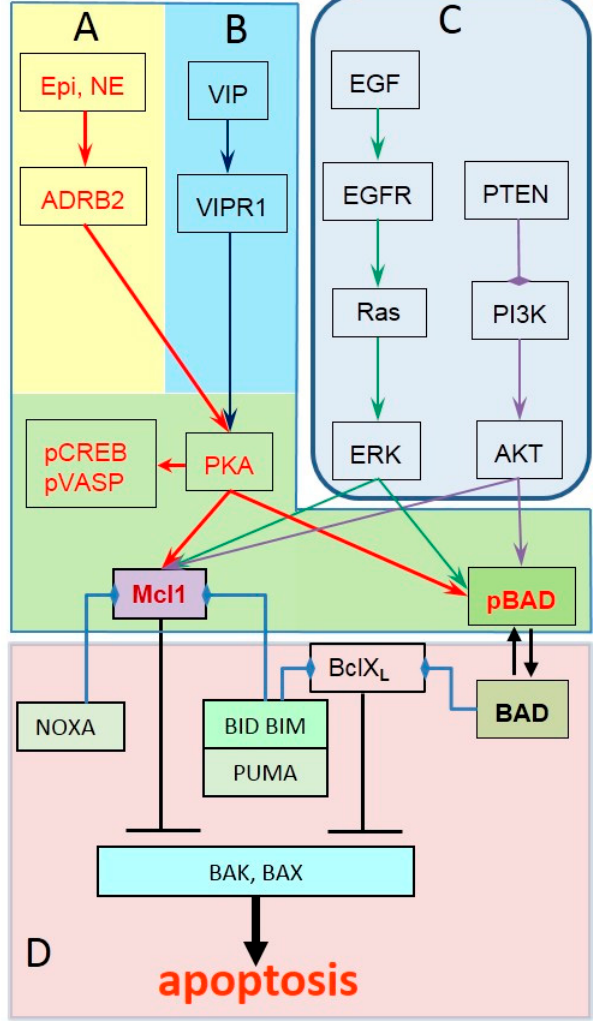
Figure 2. Anti-apoptotic signaling pathways in prostate cancer converge on MCL-1 and BAD. ( A ) Epi and NE activate ADRB2/cAMP/PKA signaling cascade that in turn phosphorylates S133CREB, S157VASP, S75BAD and increases MCL-1 expression; ( B ) Other G α s coupled GPCRs can activate cAMP/PKA and induce similar pattern of phosphorylated PKA substrates as ADRB2 activation; ( C ) GPCR-independent signaling pathways (Receptor tyrosine kinases, Ras; PI3K/AKT) can induce S75BAD phosphorylation and increase expression of MCL-1; ( D ) Expression of BclXL and/or loss of NOXA, BIM, PUMA can increase apoptosis threshold without changing BAD phosphorylation or MCL-1 levels.